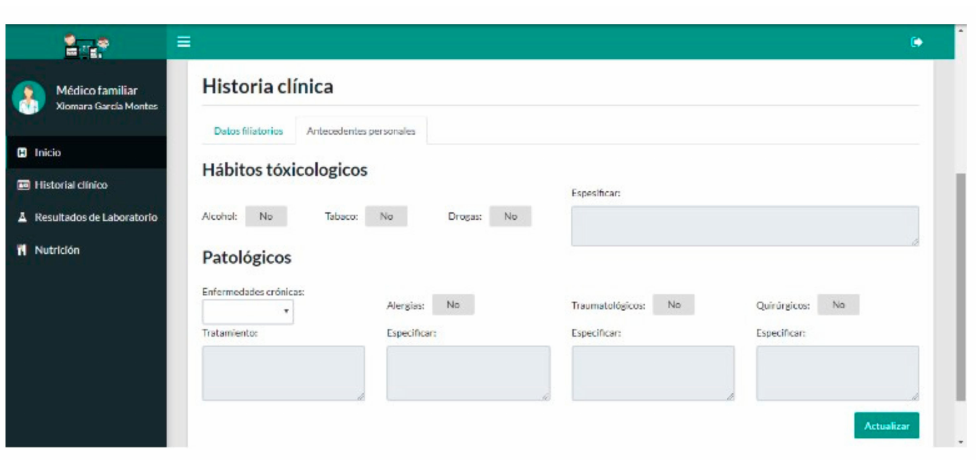
Figure 16. Physician application interface: Entry or update of personal data.